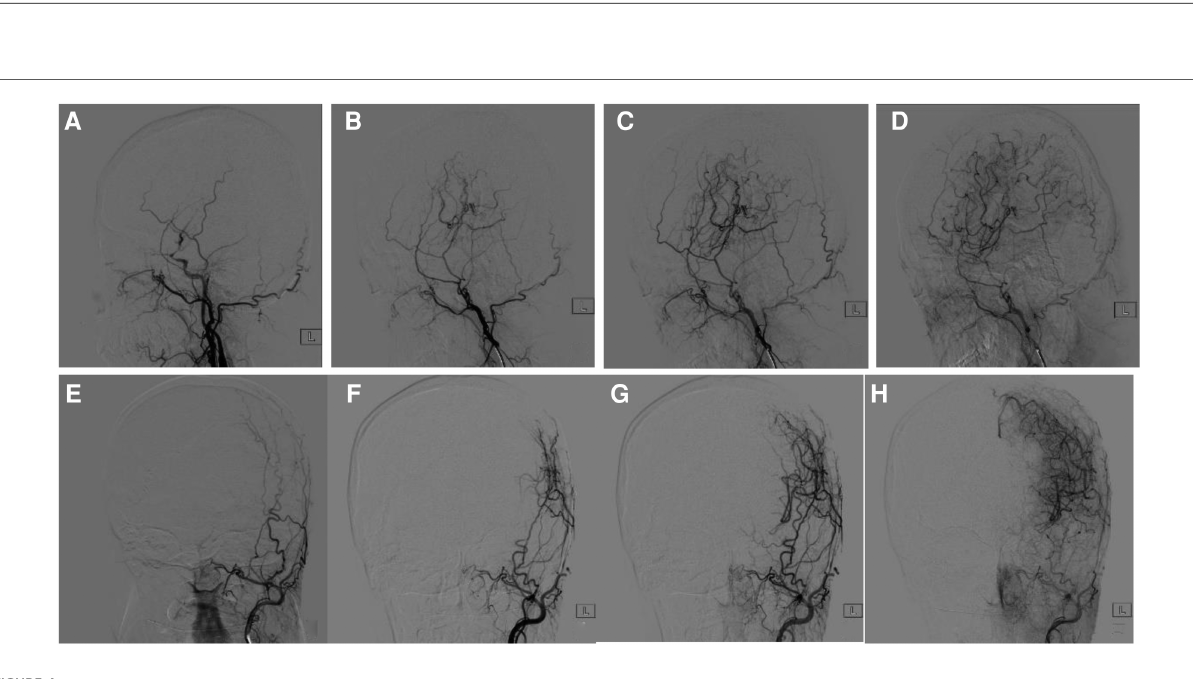
dural reversal surgery. Clinical symptoms improved signi fi cantly in almost all patients after surgery. mRS score ≤ 2 were found in 27 patients after 6 months, with a good prognosis of 81.8%.